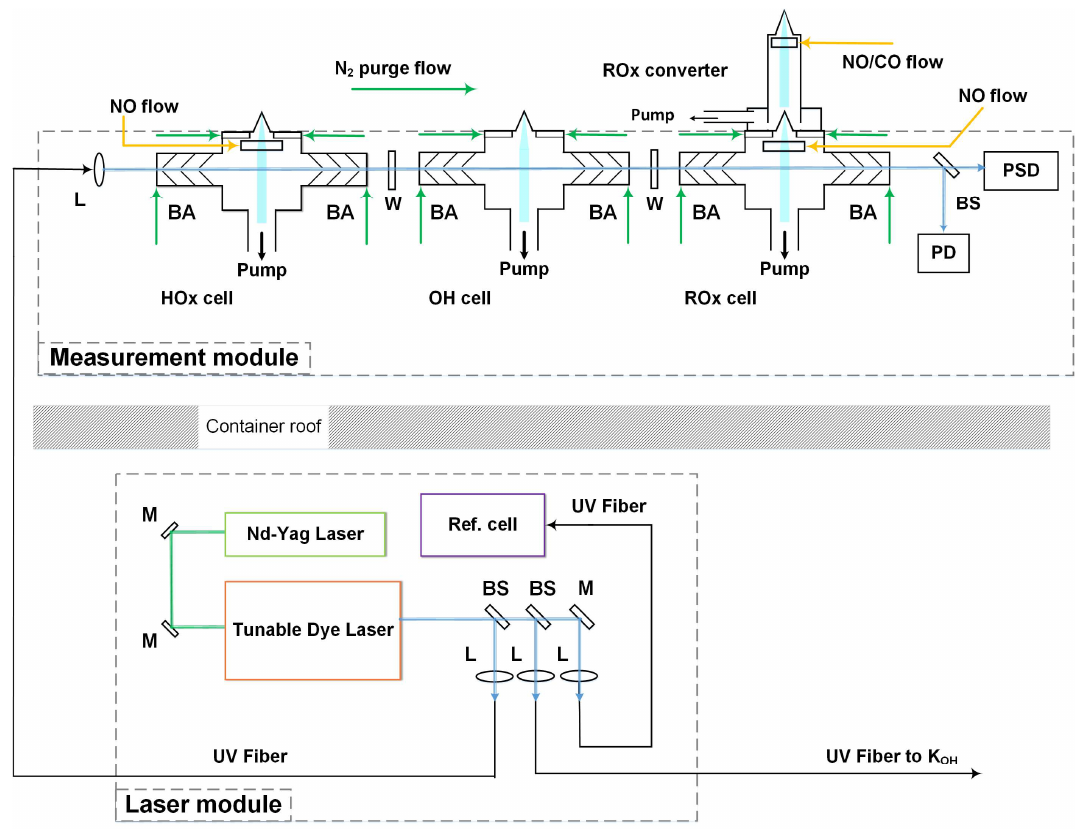
Figure 1. Schematic drawing of the LIF instrument for the detection of OH, HO 2 and RO 2 . The laser module and the measurement module were installed inside and on top of a sea container, respectively. The laser light of 308nm is split into three parts (BS: beam splitter; L: lens) and guided by optical fibers to the measurement cells, the k OH instrument and the reference cell. Ambient air is sampled into low-pressure fluorescence cells that are separated by windows (W). Reactive gases (NO, CO) are added into the HO x − and RO x − cells and the RO x converter. Baffle arms (BAs) and fluorescence cells are continuously purged with N 2 . The position and the power of the laser beam are monitored by a photodiode (PD) and a position-sensitive diode